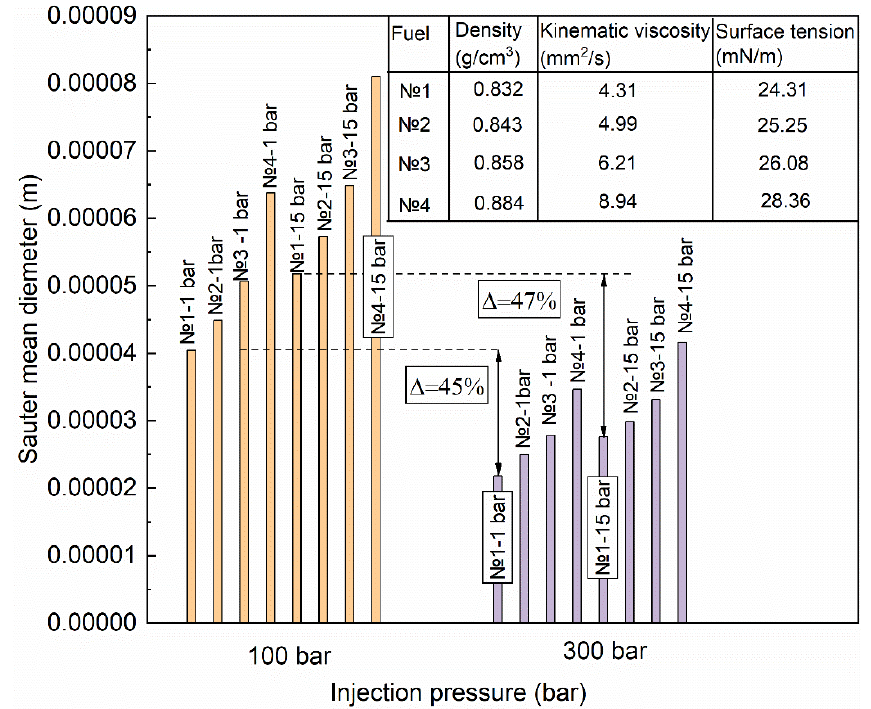
Figure 4. Variation of Sauter mean diameter with an increase in the injection and gas pressure (comparison using the data from [48]).